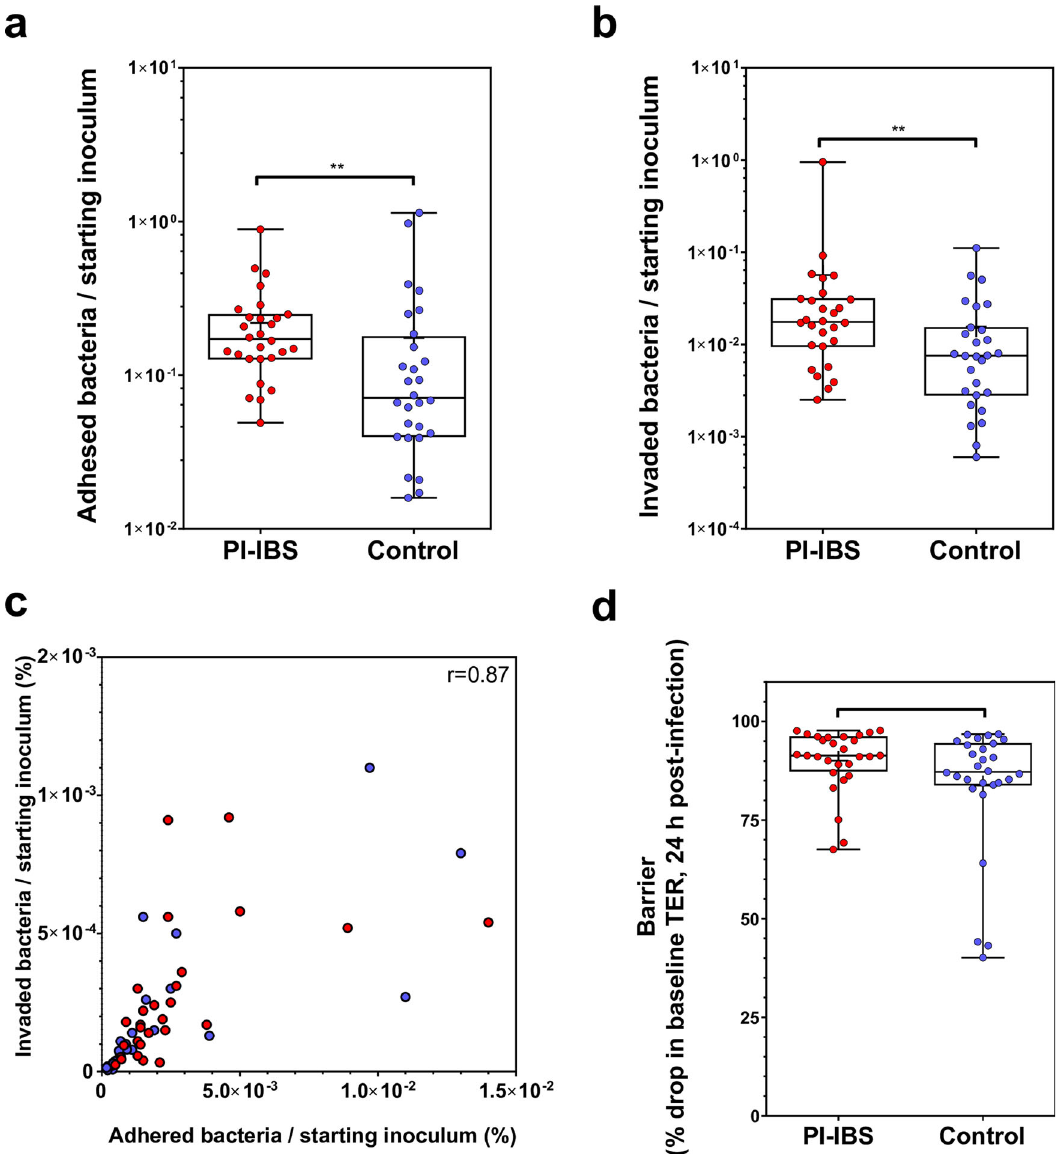
Fig. 4 In vitro pathogenicity phenotypes of PI-IBS and control C. jejuni isolates. a PI-IBS causing C. jejuni isolates demonstrate greater adhesion to T84 epithelial cells. b Using gentamycin protection assay, PI-IBS isolates demonstrate greater intracellular invasion compared to the control isolates. c Positive correlation between adhered and invaded bacteria on T84 colonocytes (non-parametric Spearman correlation, r = 0.87; p -value < 0.0001). d T84 colonocytes were grown as epithelial monolayers with transepithelial resistance (TER) > 750 Ω cm 2 . No differences in % drop in TER in monolayers exposed to PI-IBS causing C. jejuni isolates compared to control isolates. ( n = 28/group, Mann – Whitney U test). *All box plots show the 25th and 75th percentile, whiskers extending to the min and max values with all data points shown. Raw data are available in Supplementary Data